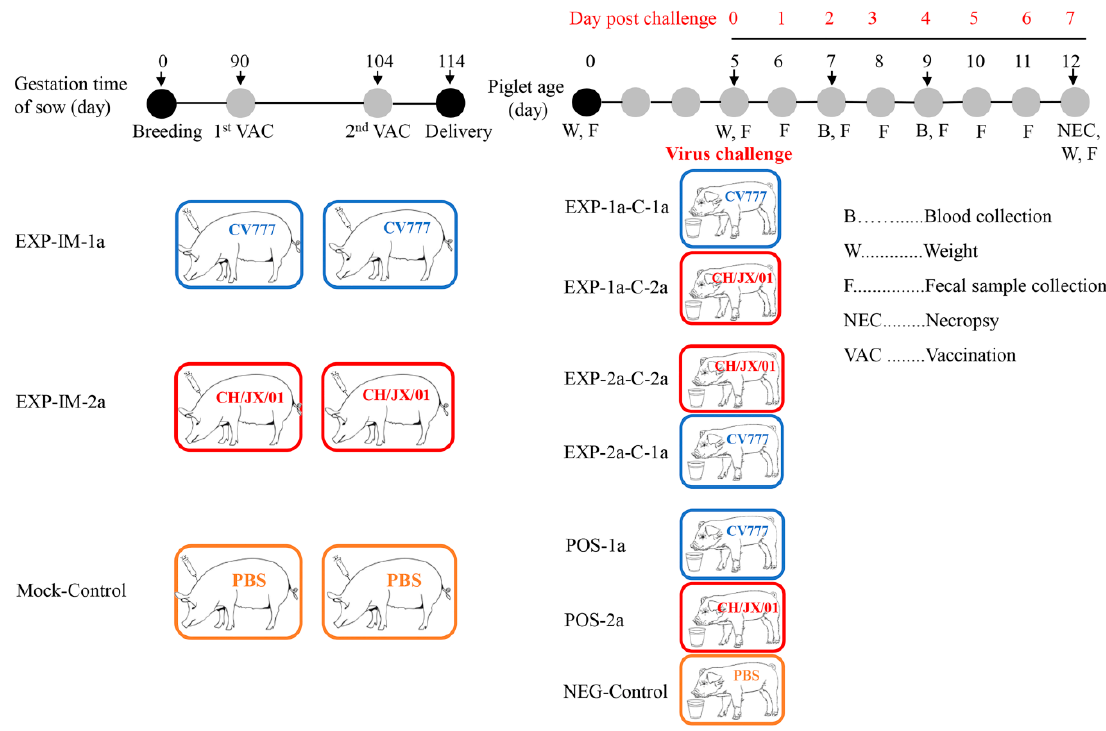
Figure 1. Experimental design and sample collection. The top line indicates the day post porcine epidemic diarrhea virus (PEDV) challenge, the second line on the left indicates the gestation stage of sows, and the right line indicates the age of neonatal piglets.